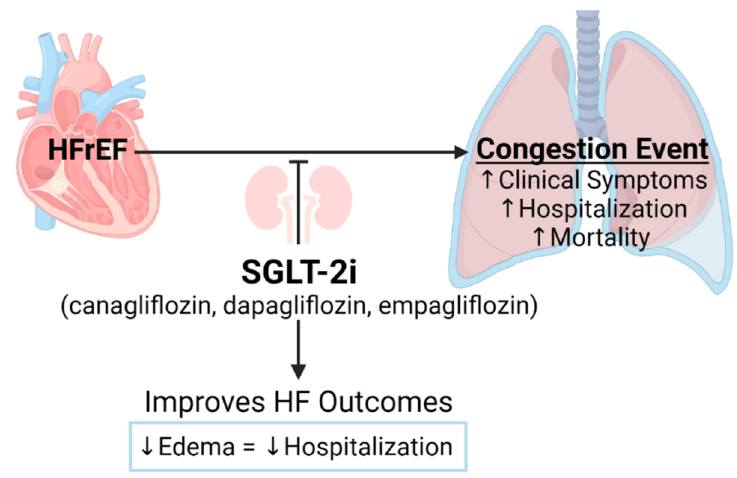
Figure 2. Schematic presentation of SGLT-2i Contribution to Attenuation of Edema/Congestion in HFrEF. Created with BioRender.com.